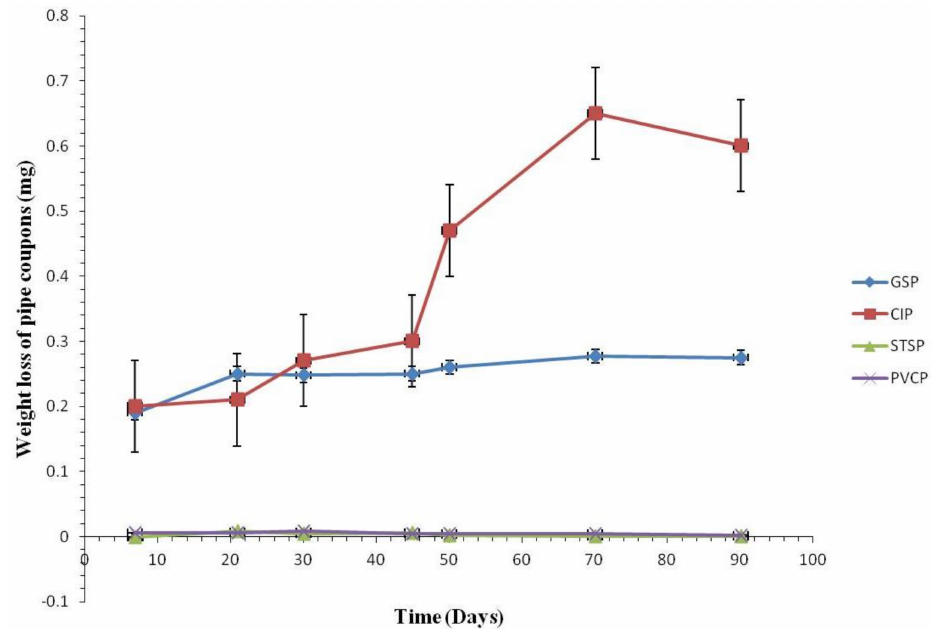
Figure 11. Weight loss of coupons with RW in galvanized steel, cast iron, stainless steel, and polyvinyl chloride pipes over time with standard error bars.